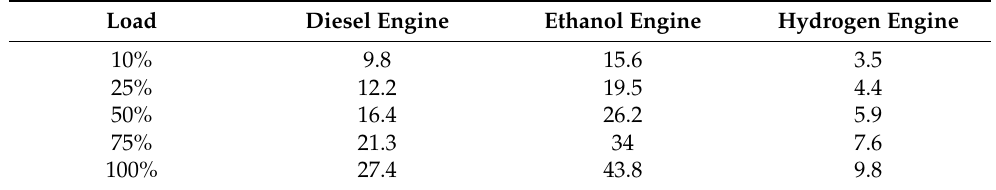
Table 5. Mass per injection (mg) of diesel, ethanol and hydrogen engine models under different loads.